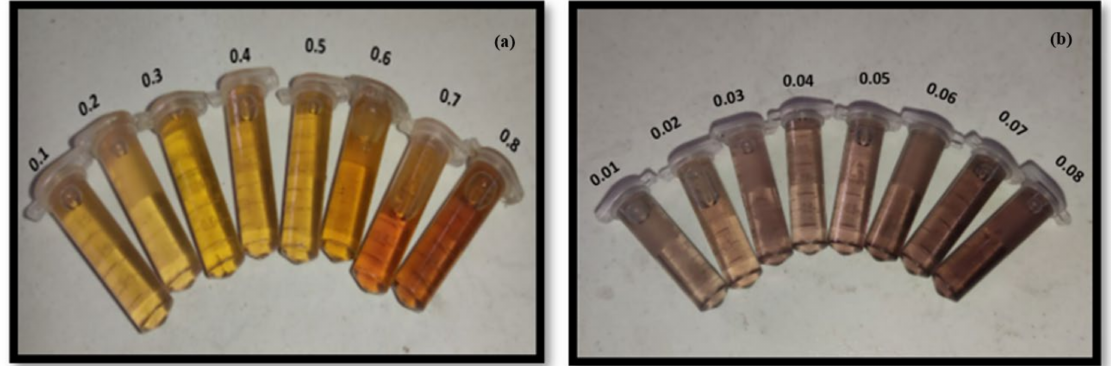
Figure 10. Different concentrations in mM of ( a ) Catechol ( b ) Resorcinol.